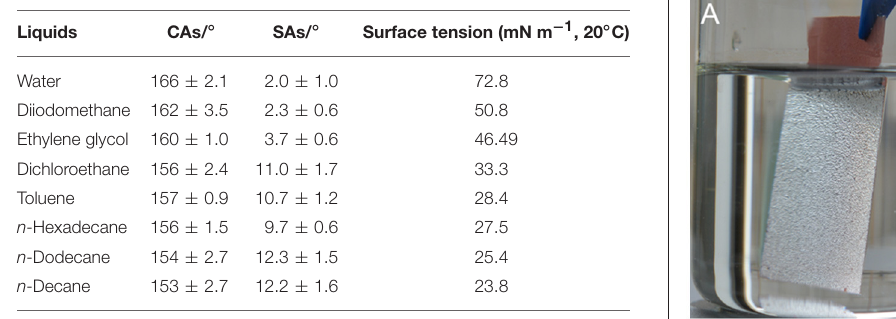
TABLE 1 | Superamphiphobicity.